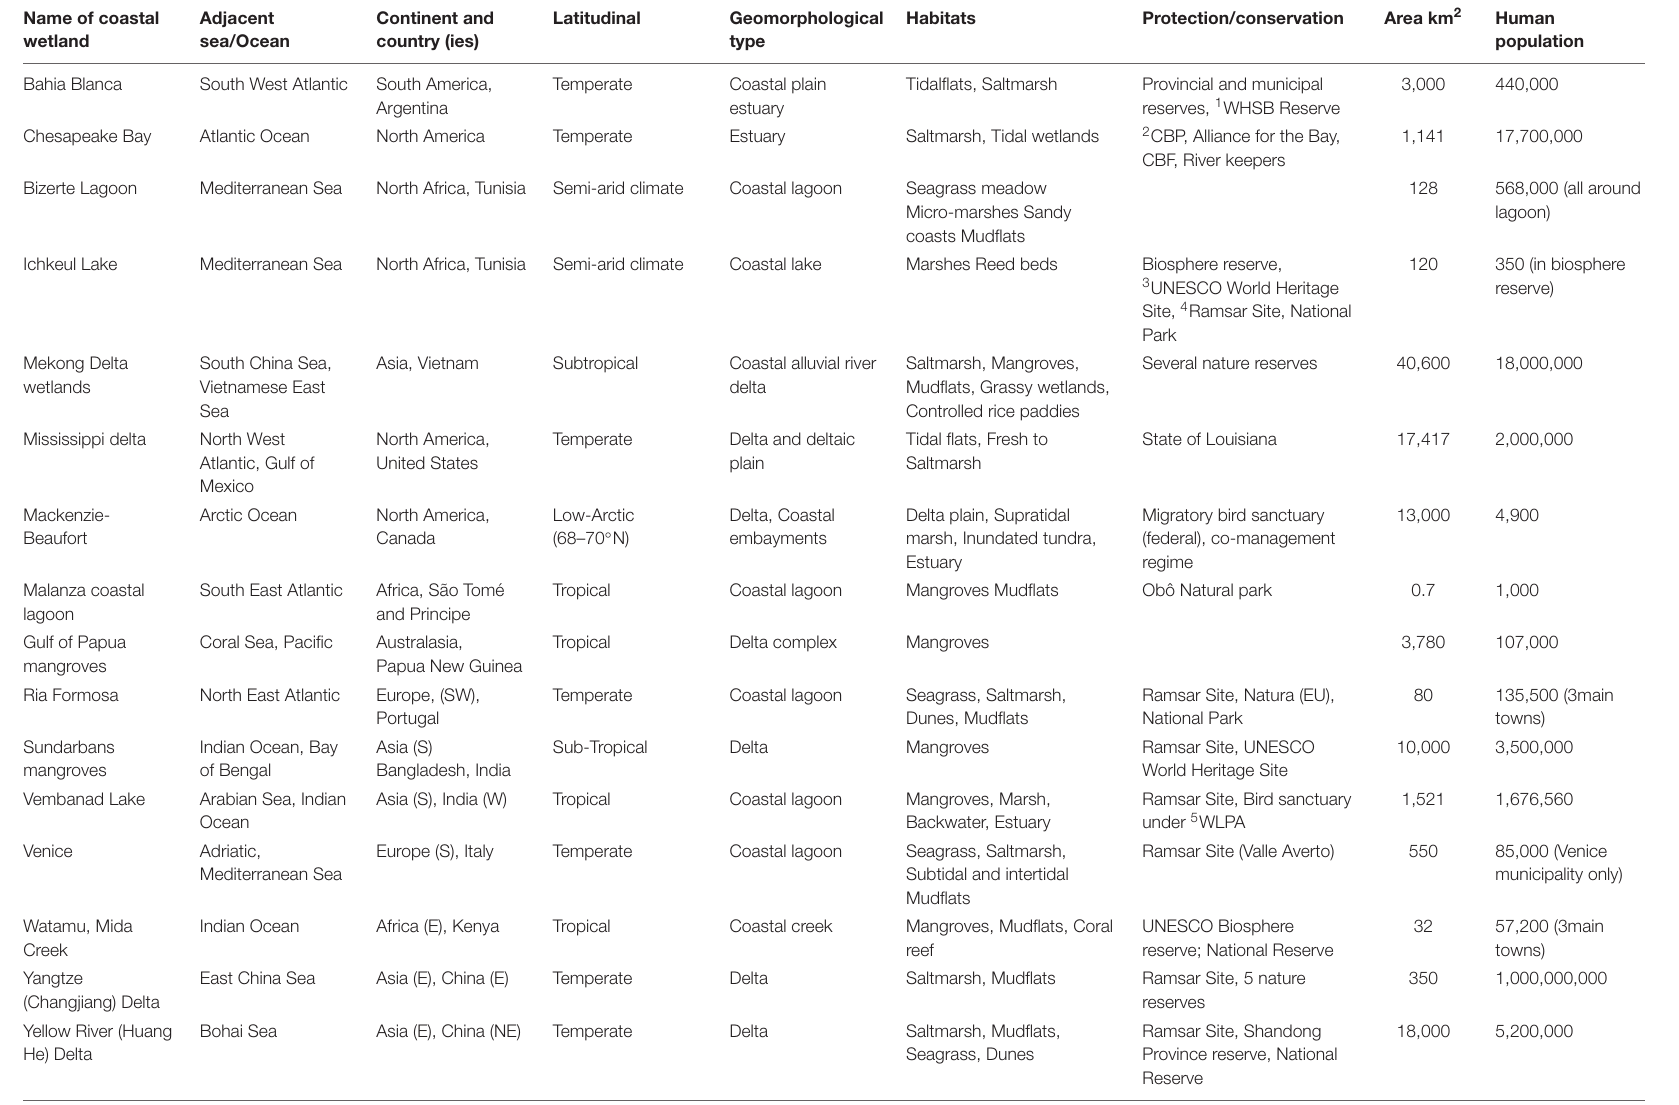
TABLE 1 | List of coastal wetlands used as examples in this article, with some of the descriptors. Name of coastal